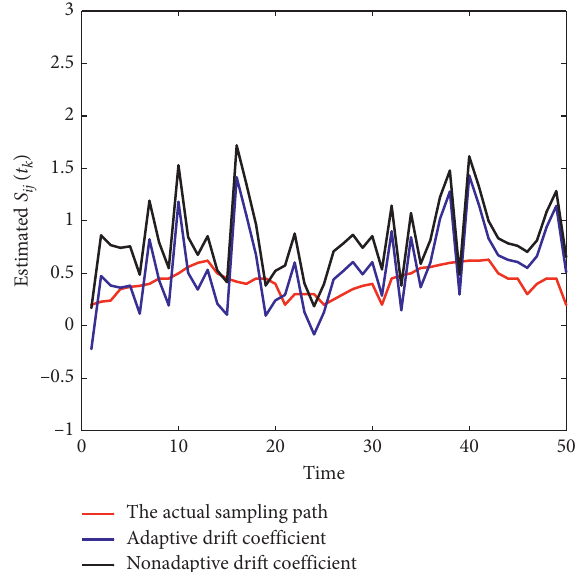
Figure 5: The estimated social tie for different drift parameters with initial conditions given in Example